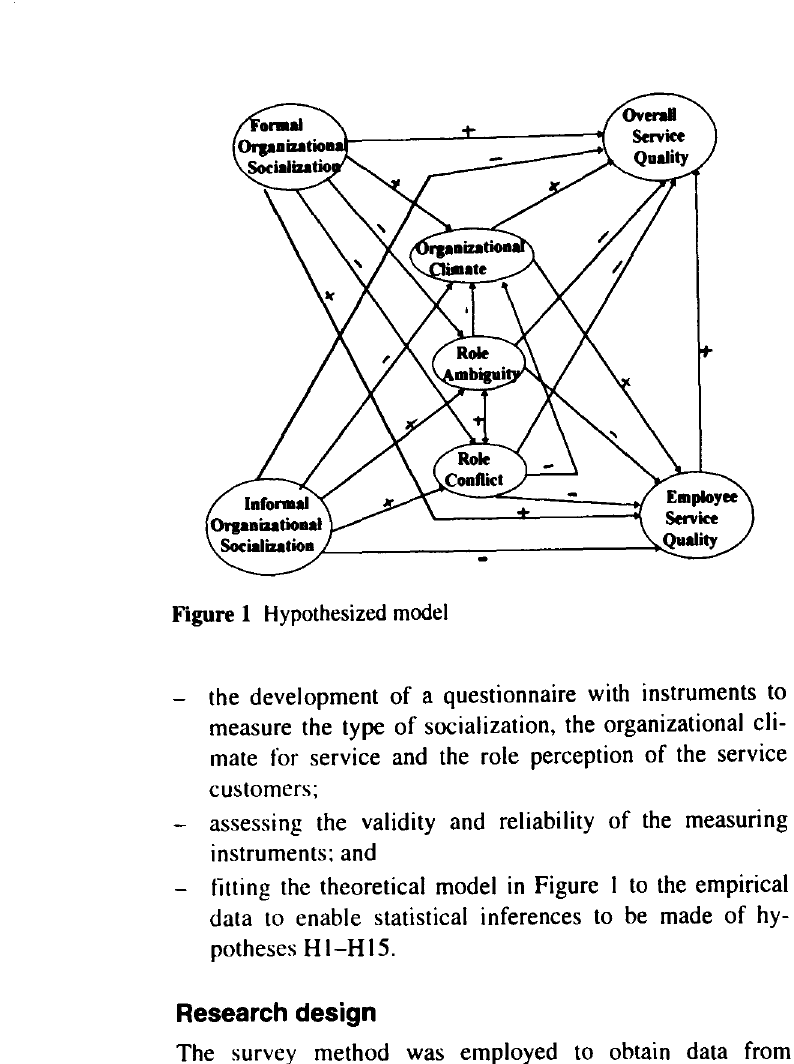
Figure 1 Hypothesized